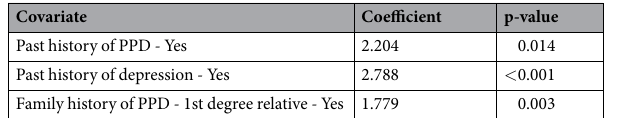
Table 5. Significant covariates of a linear model for postpartum EPDS scores. The full model is provided in Suppl. Table